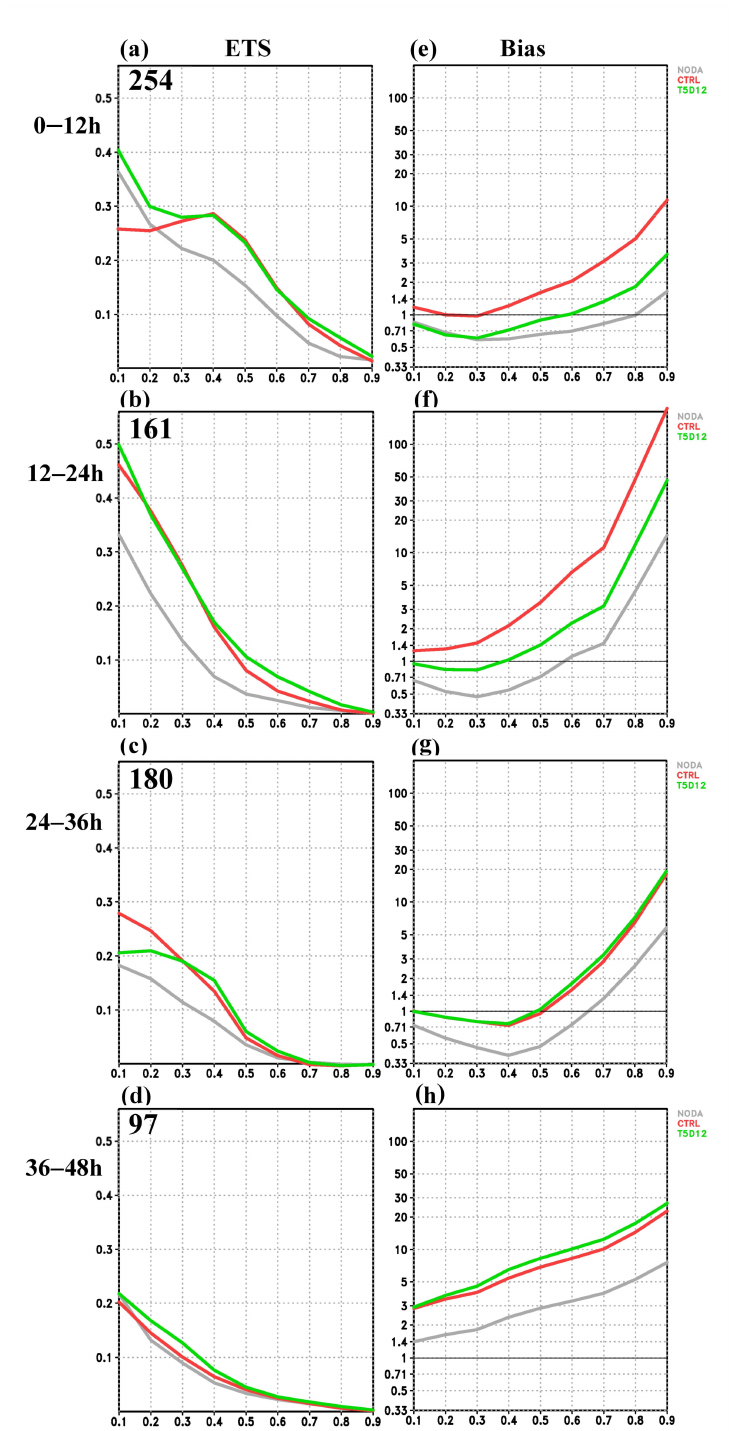
Figure 6. The ETS (left column, ( a – d )) and bias (right column, ( e – h )) of rain forecasts from 32 ensemble members of NODA (gray), CTRL (red), and T5D12 (green) using rain in NR as the truth. Rain thresholds (the abscissa) are normalized by the rain maxima over Taiwan in NR, which are denoted on the top of the left column for each 12-h period. The time periods are ( a , e ) 0–12 h, ( b , f ) 12–24 h, ( c , g ) 24–36 h, and ( d , h ) 36–48